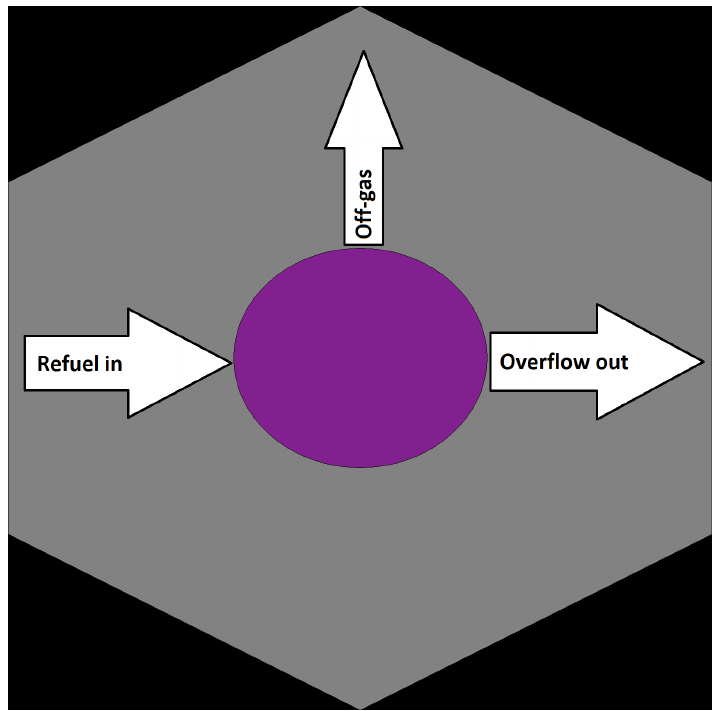
Figure 2. Fuel salt channel with the mass flows captured in the